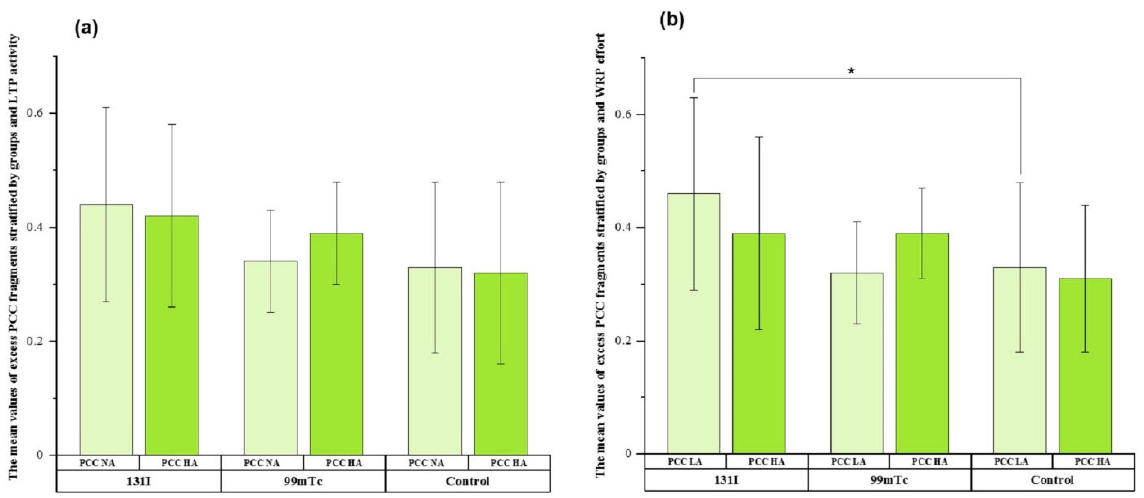
Figure 3. Frequencies of excess PCC fragments in NA and HA LTPA ( a ) and LA and HA WRPE ( b ) in peripheral lymphocytes of the three groups. * p ≤ 0.05.